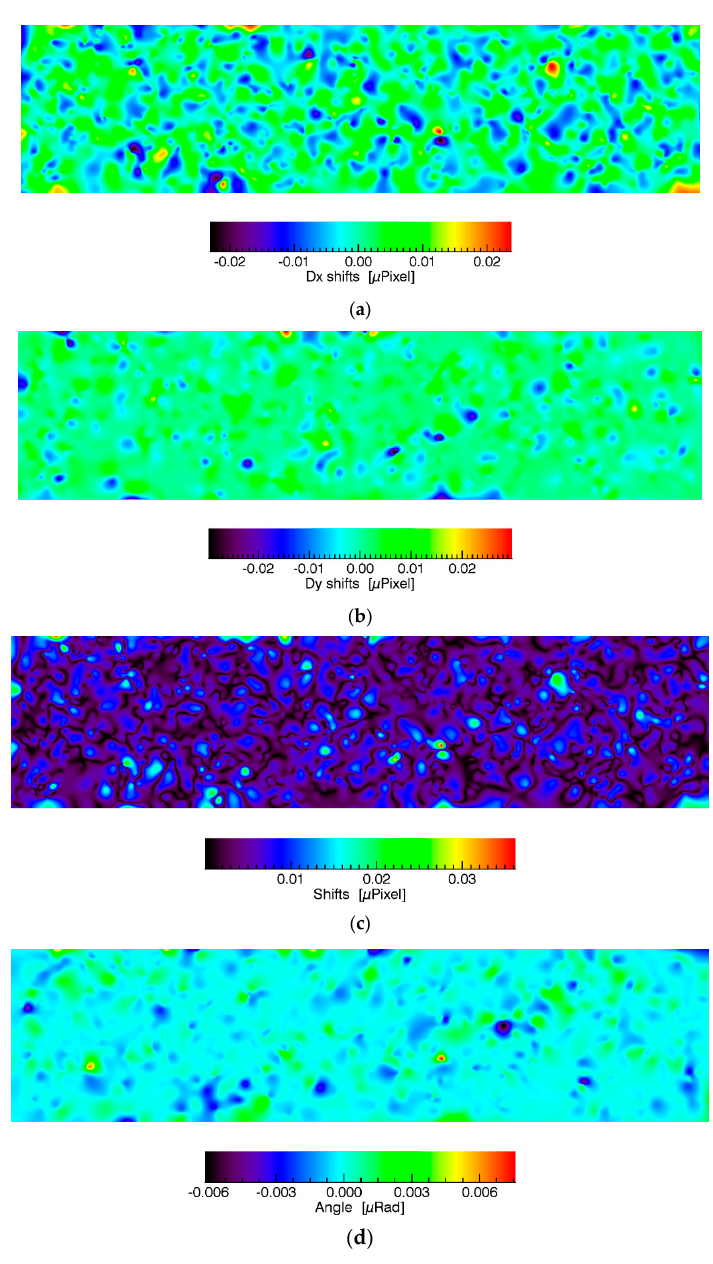
Figure 9. Interpolated local distortions that represent the accuracy of the geometry module for visual assessment. ( a ) Dx shifts, ( b ) Dy shifts ( c ) shifts in μ pixel and angle distortions ( d ) in μ Rad. Please note that there are no significant gradients at the displayed micro-unit scale.